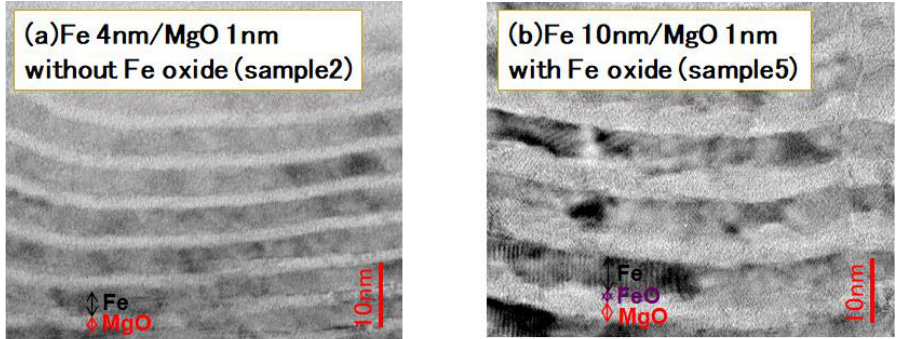
Figure 2. Images by transmission electron microscope (JEM-4000EX, JEOL) for ( a ) Fe(4 nm)/MgO(1 nm) (sample2) and ( b ) intentionally oxidized Fe(10 nm)/MgO(1 nm)